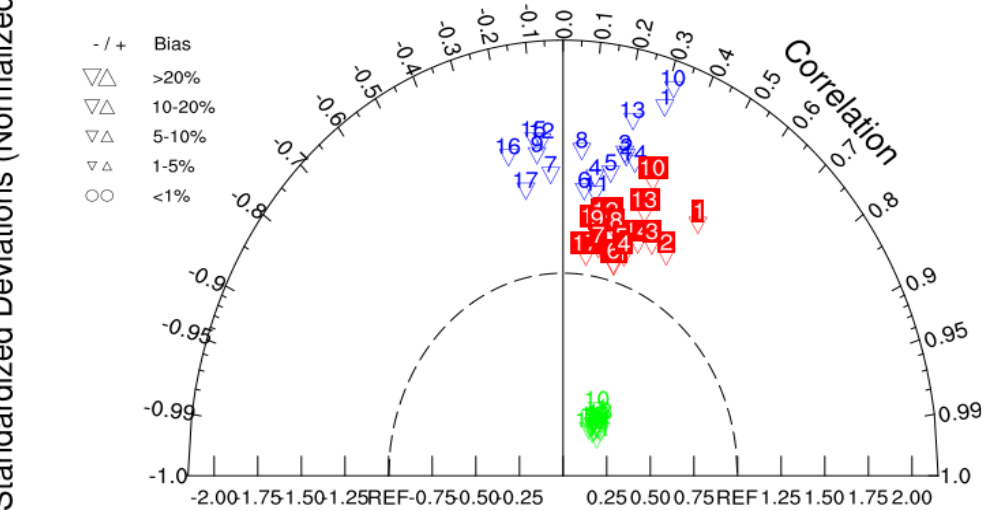
Figure 4. Taylor diagram for the 1060–2016 Temperature and climate drivers (ENSO-blue, PDO-red, AMO-green). Mexico southern is represented by the points 1–5, Central America by the points 6–12, and the Caribbean by 13–17.